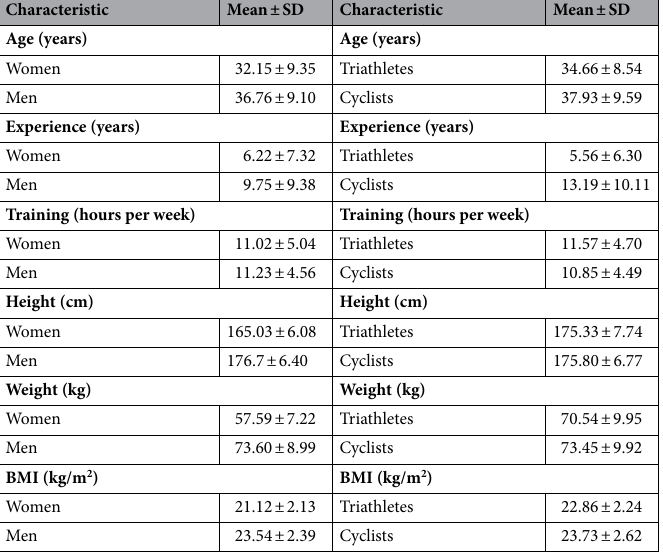
Table 1. Participant general characteristics. SD: Standard deviation; BMI: Body mass